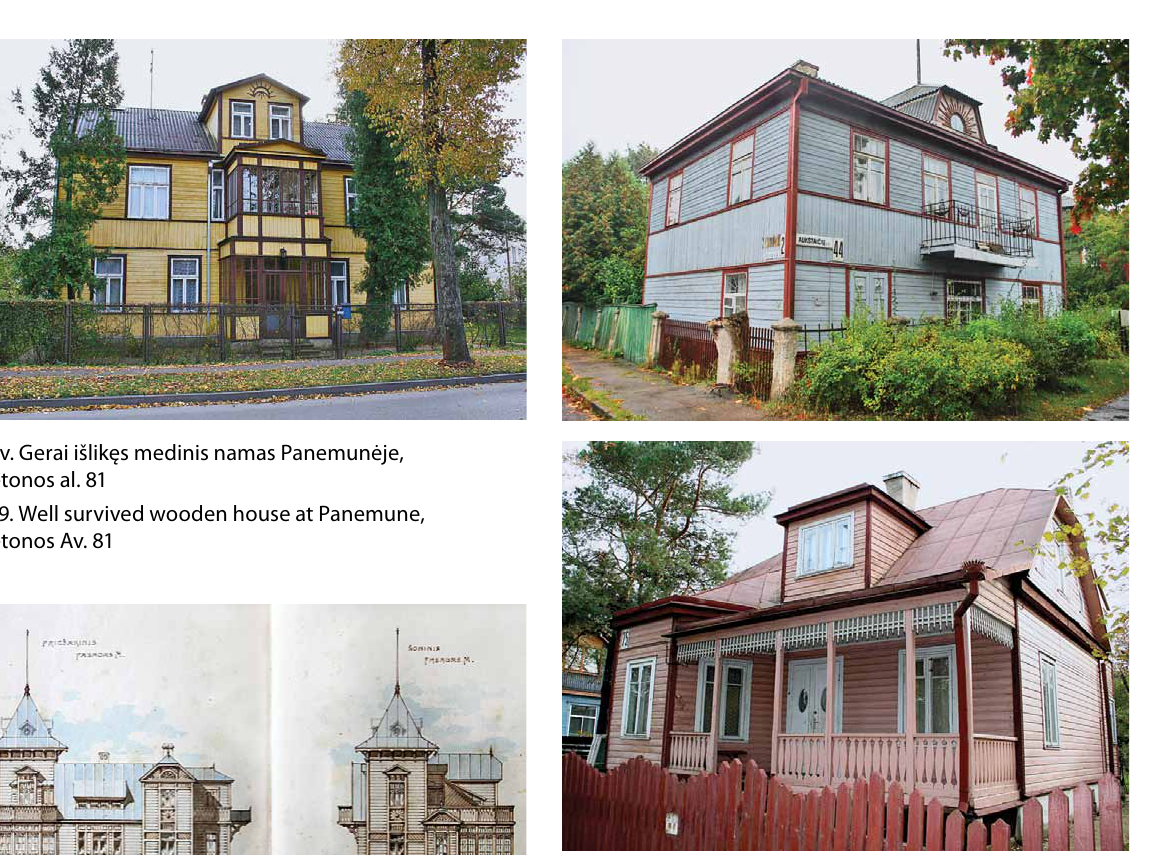
tabilizacijos. Todėl išsaugota istorinė aplinka miestų gyventojams teikia psichologinio stabilumo, saugumo bei istorinio tęstinumo jausmą“ (Čepaitienė 2011: 150).